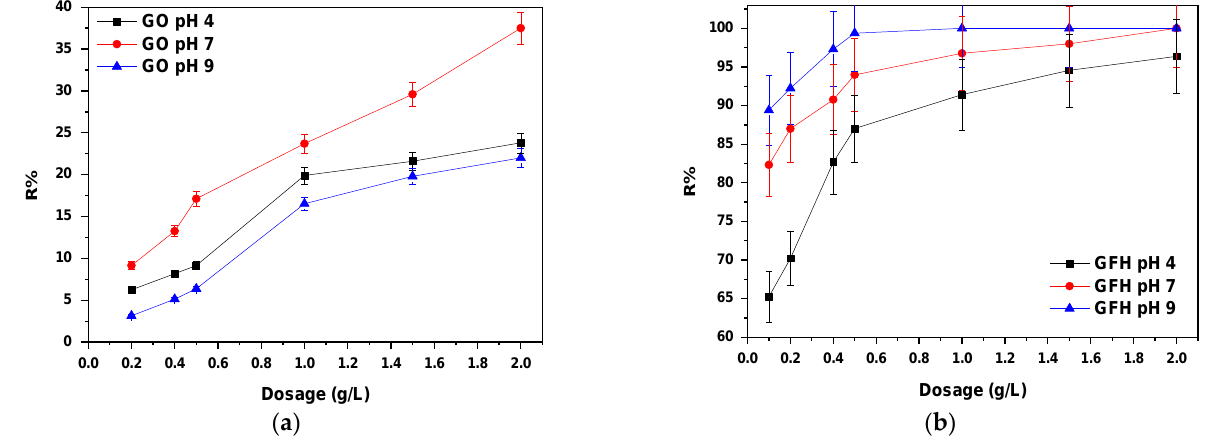
Figure 1. Comparison and effect of adsorbent dose on As(III) R% removal ( a ) on GO and ( b ) on GFH; initial As(III) concentration 100 μg/L, pH 4.0, 6.0, 7. 0 ± 0.1, T = 298 K, contact time 24 h, in